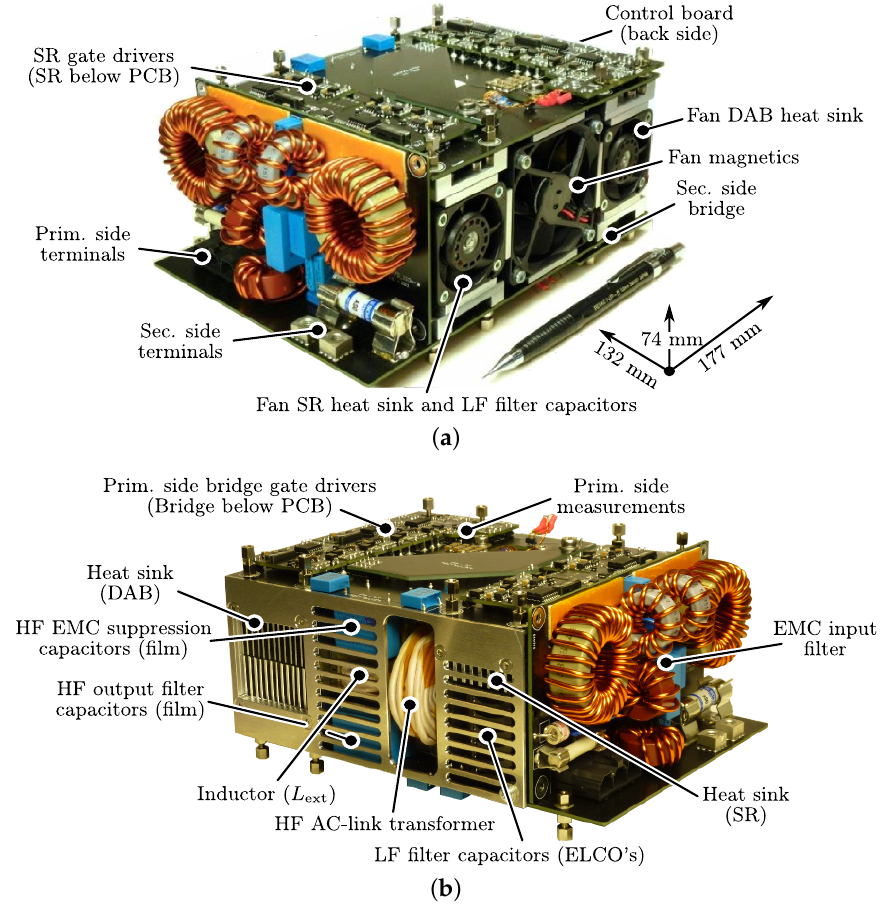
Figure 19. The 3.7 kW, 1-S (single-stage), single-phase, bidirectional, and isolated DAB ac-dc hardware demonstrator: ( a ) Front-right view; ( b ) Front-left